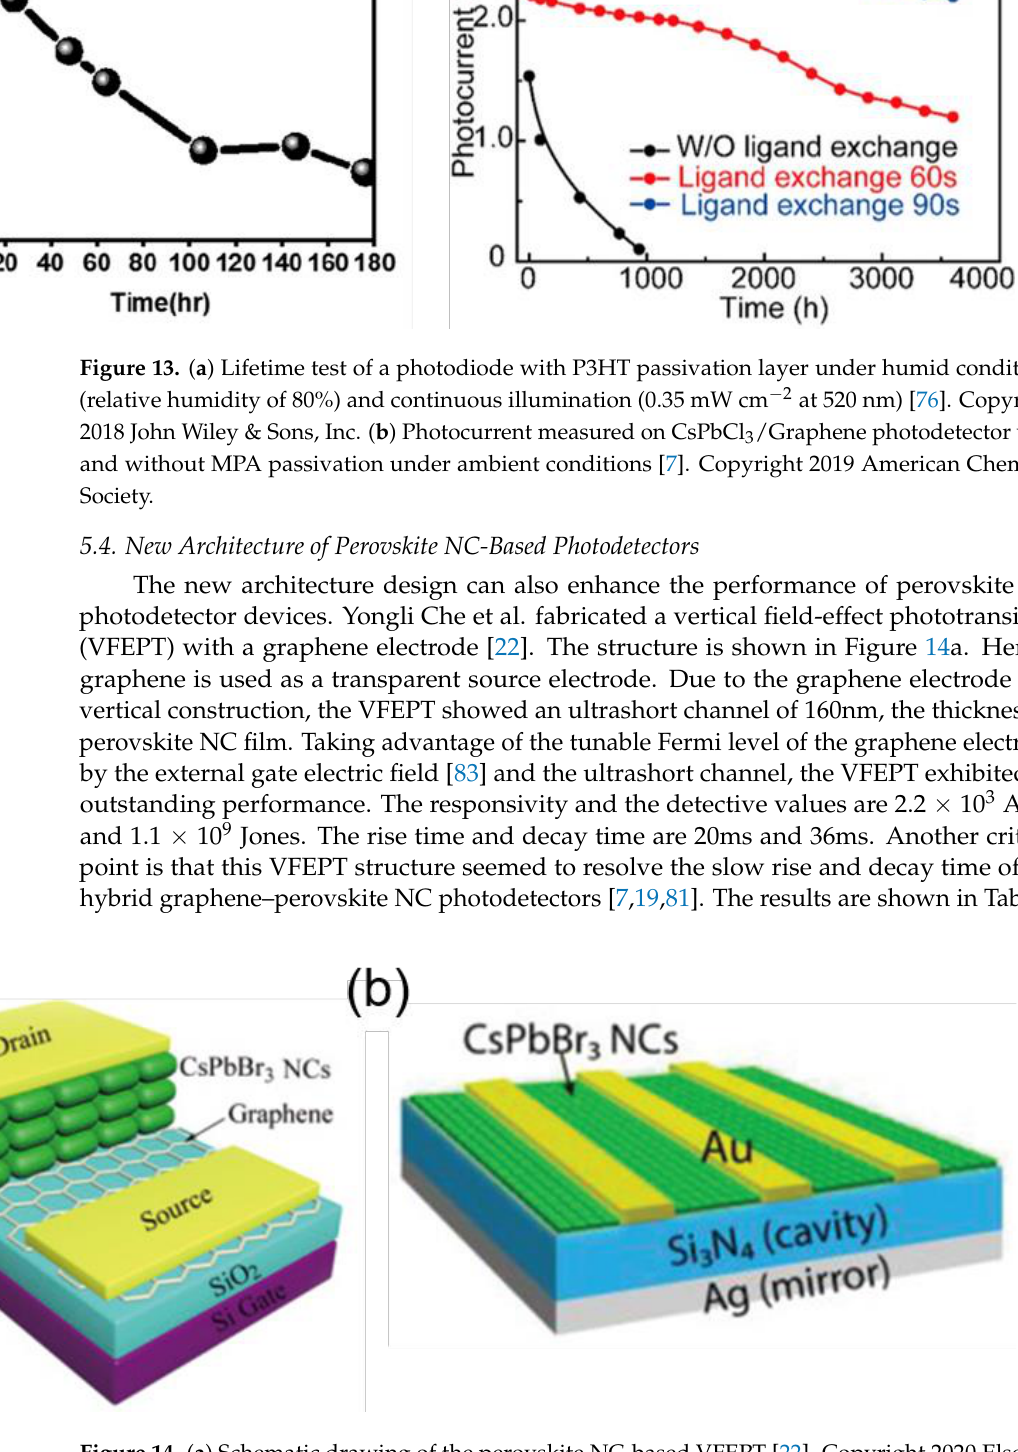
Inorganics 2023 , 11 , x FOR PEER REVIEW